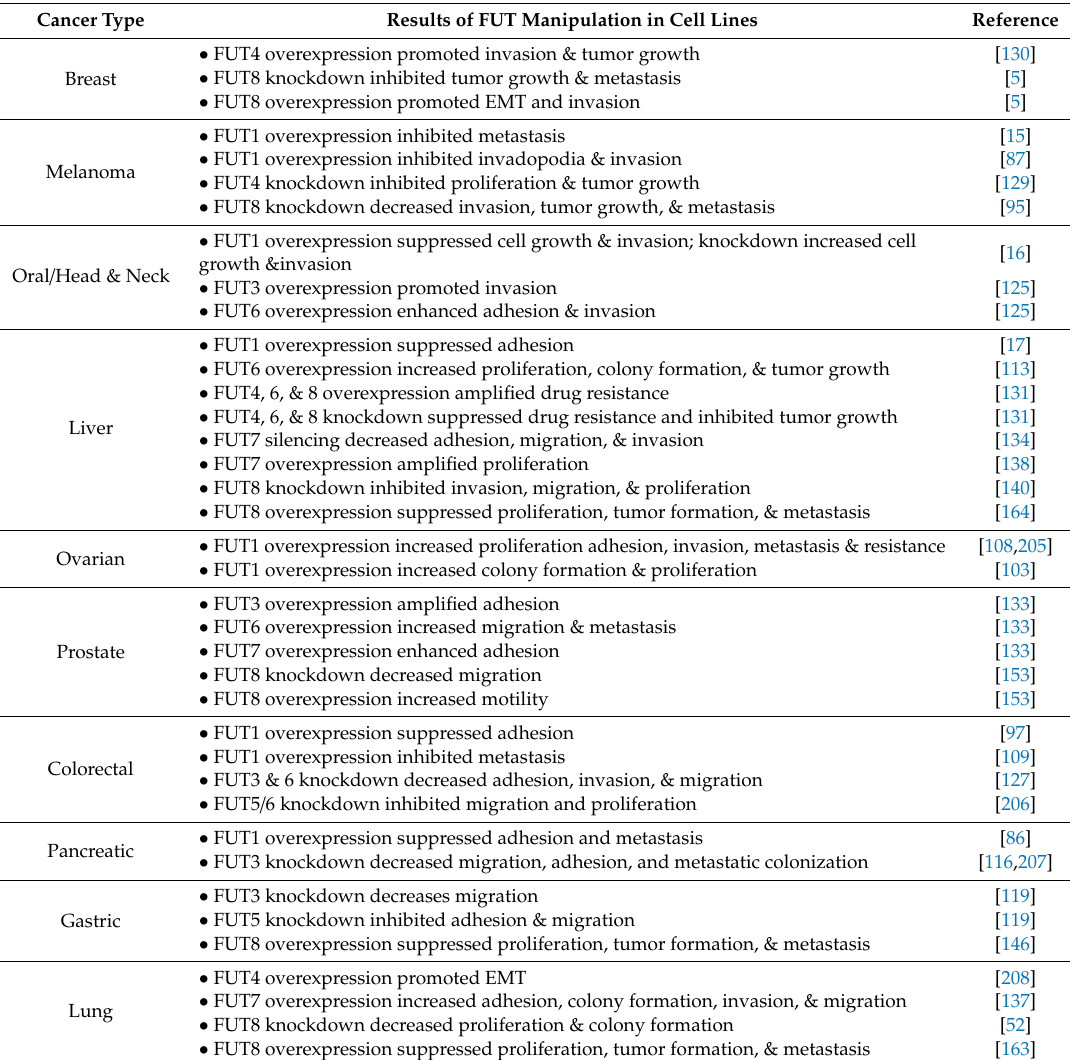
Table 7. Summary of studies that have manipulated FUTs and documented biological outcomes in tumor cell